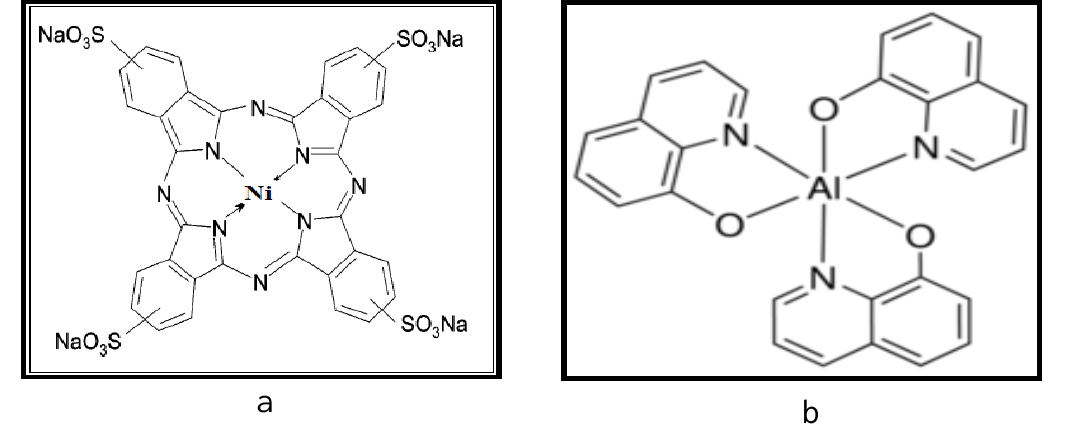
Fig.2: Strutral formula a. Molecular structure of nickel (II) phthalocyanine